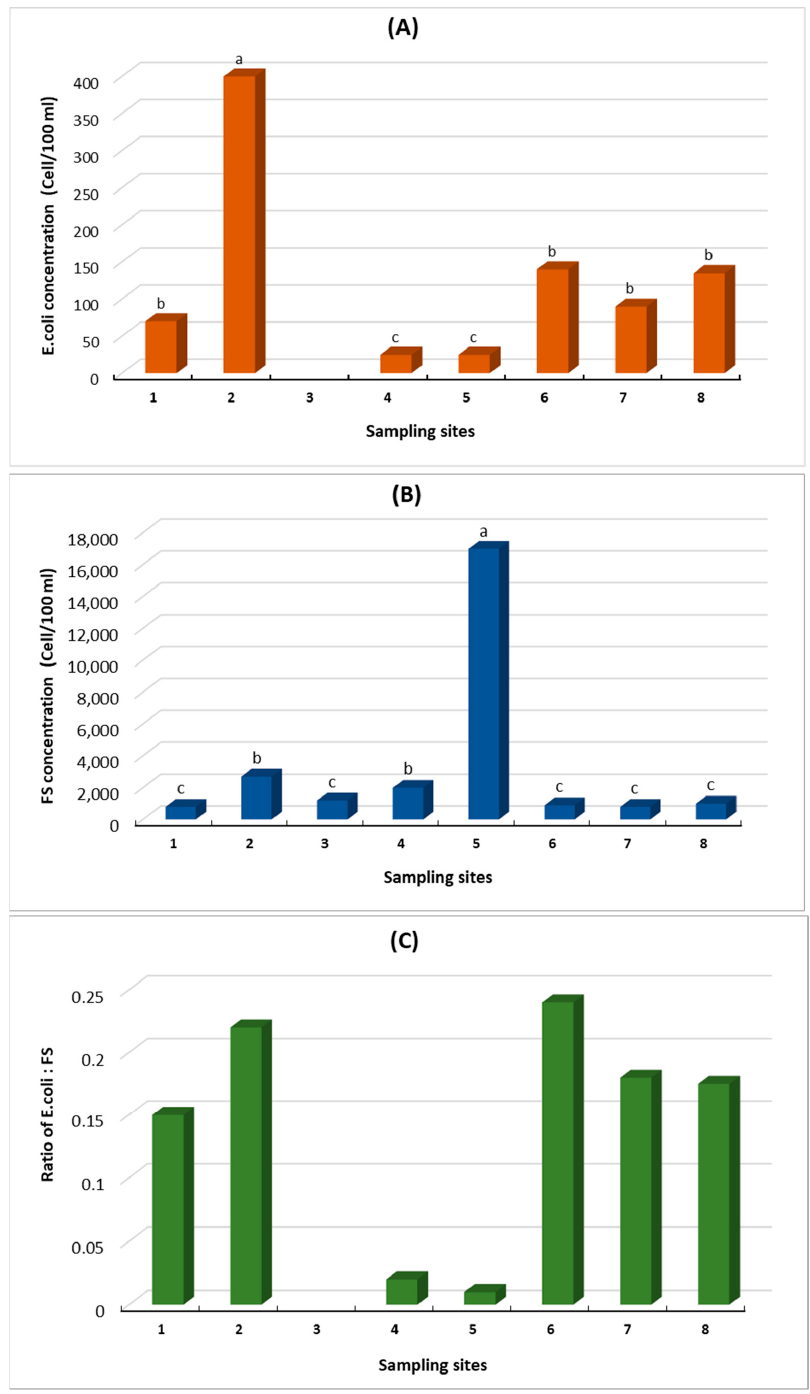
Figure 2. ( A ). Concentrations of E. coli in environmental water samples taken during low tide from around Blakeney Point. Values represent mean data. ( B ). Concentrations of Faecal Streptococci (FS) from environmental water samples taken during low tide from around Blakeney point. Values represent mean data. ( C ). The ratio of E. coli to Faecal Streptococci in water samples collected from around Blakeney Point during a low tide period. (1) Simpoles Head, (2) Freshers Creek, (3) Mortson Creek, (4) Blakeney Harbour, (5) Blakeney Harbour Sluice, (6) Scaupe Run, (7) River Cley (below weir), (8) River Cley (above weir). Lower case letters above the bars ( A , B ) a, b, c, denote the significance between the sites at p <